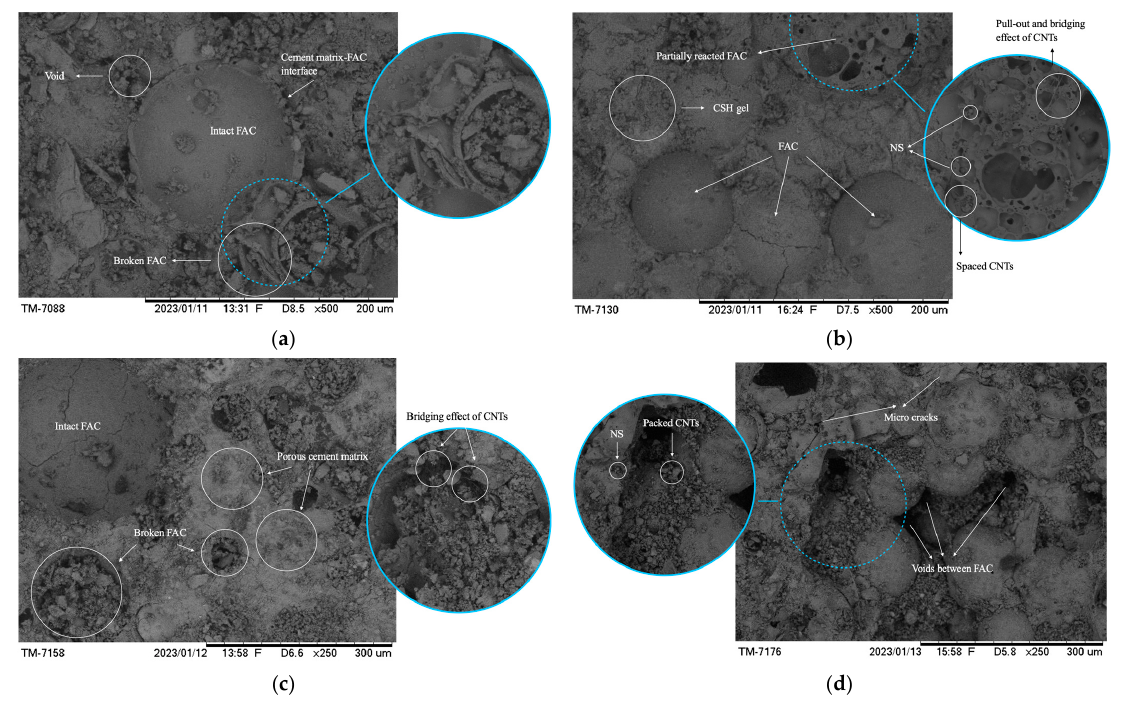
Figure 14. Morphology of LWCM: ( a ) RS; ( b ) C15S2; ( c ) C5S0; ( d ) C45S10.